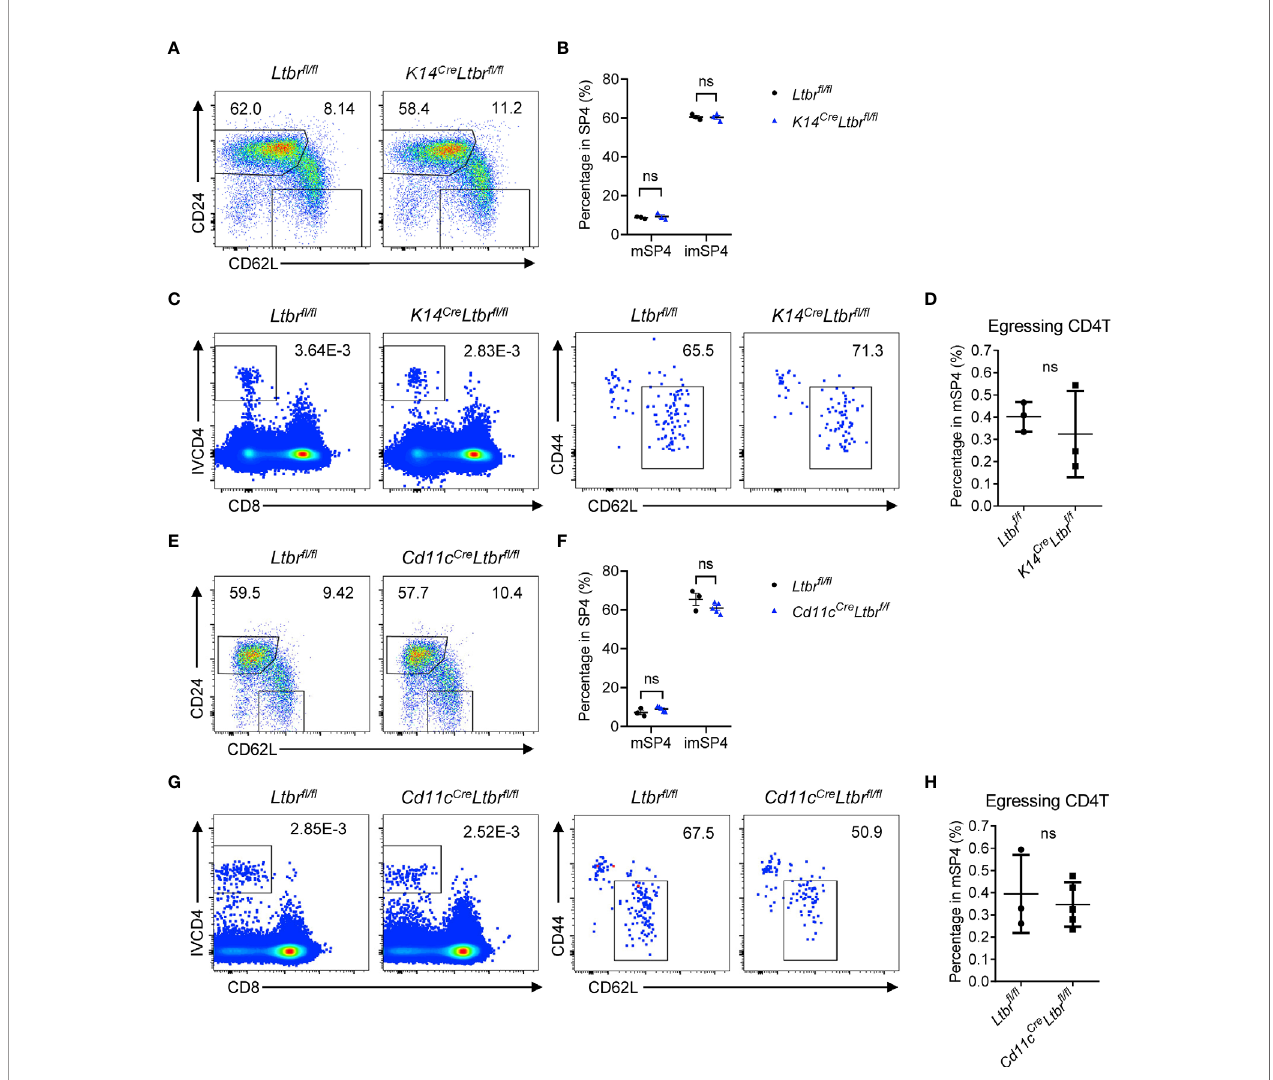
FIGURE 2 | TEC- or DC-derived LT b R does not regulate thymic egress. (A, B) Flow cytometric analysis of SP4 thymocytes in K14 Cre Ltbr fl / fl and littermate control mice. (A) Representative dot plots are shown. (B) The graphs display the statistical analysis of the percentage of immature or mature CD4 + SP thymocytes among total SP4 population. Mean ± SEM; n = 3. Data are representative of at least three independent experiments. (C, D) Flow cytometric analysis of egressing CD4 + T cells in K14 Cre Ltbr fl / fl and littermate control mice. (C) Representative dot plots of IVCD4-labeled thymocytes are shown (left). Egressing CD4 + T cells are gated from IVCD4-labeled thymocytes (right). (D) The graphs display the statistical analysis of the percentage of egressing CD4 + T cells among total mSP4. Mean ± SEM; n = 3. Data are representative of at least three independent experiments. (E, F) Flow cytometric analysis of SP4 thymocytes in Cd11c Cre Ltbr fl / fl and littermate control mice. (E) Representative dot plots are shown. (F) The graphs display the statistical analysis of the percentage of immature or mature thymocytes among total SP4 population. Mean ± SEM; n = 3 and 5. Data are representative of two independent experiments. (G, H) Flow cytometric analysis of egressing CD4 + T cells in Cd11c Cre Ltbr fl / fl and littermate control mice. (G) Representative dot plots of IVCD4-labeled thymocytes are shown (left). Egressing CD4 + T cells are gated from IVCD4-labeled thymocytes (right). (H) The graphs display the statistical analysis of the percentage of egressing CD4 + T cells. Mean ± SEM; n = 3 and 5. Data are representative of at least three independent experiments. ns, P > 0.05 (unpaired Student ’ s t